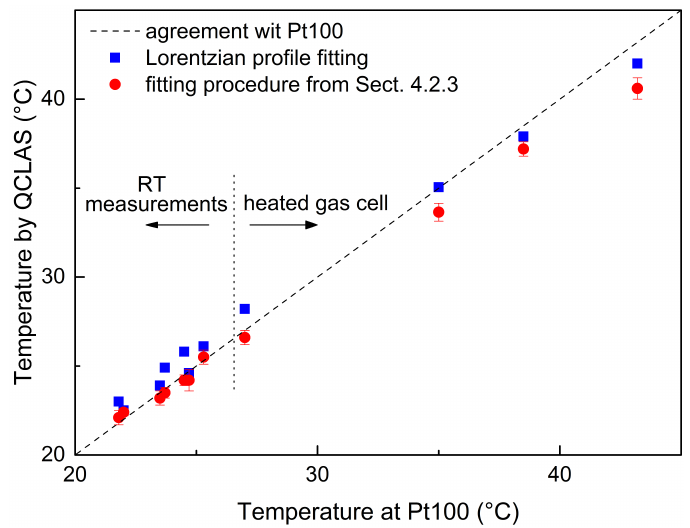
Figure 9. Temperature determined from QCLAS compared to the temperature measured by the Pt100 sensor. The blue square data points represent the temperature as derived from simple Lorentzian profile fitting of the absorption lines (see Section 4.1), whereas the data points with red circles were obtained with the fitting algorithm described in Section 4.2.3. Laser repetition rate: 50 kHz, current ramp duration: 10 ms, τ s = 16.7 ms, averaging time: 1